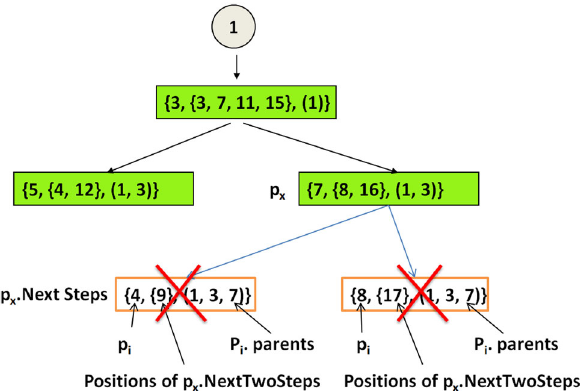
Fig. 10 Example of generating new NextSteps , containing p 4 and p 8 , where p